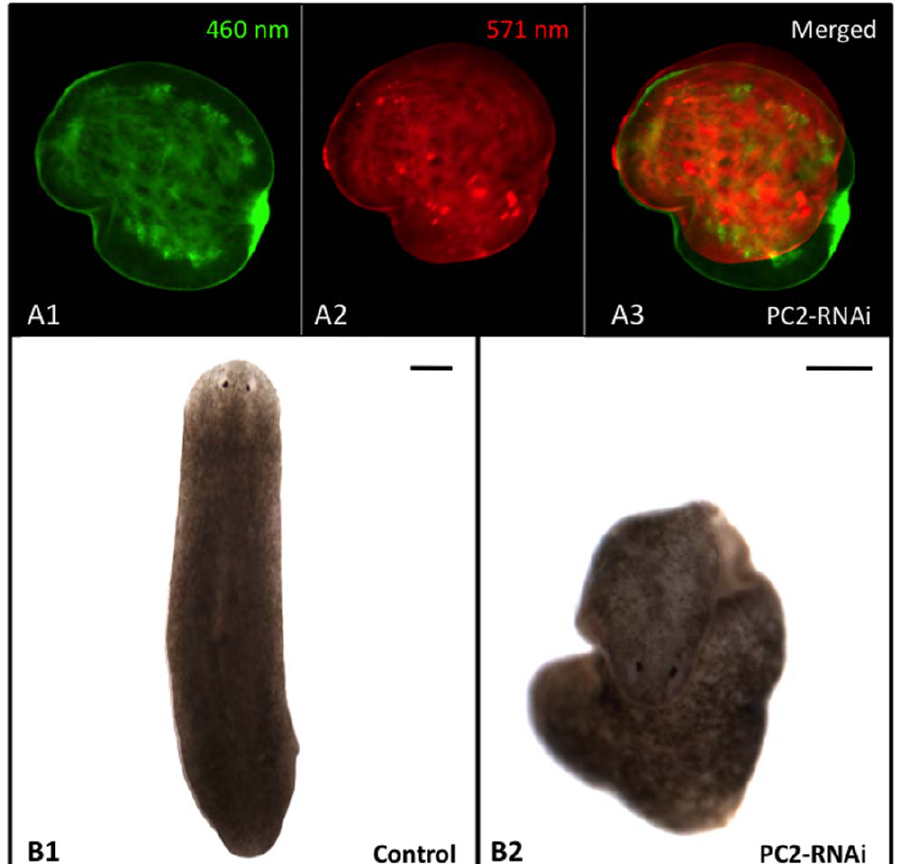
Figure 1. Need for An Improved Planarian Immobilization Technique. ( A ) Membrane Voltage Reporter Dye Assay . When consecutive images of a single planarian trunk fragment at 24 hours of regeneration showing ( A1 ) CC2 (460 nm) and ( A2 ) DiBAC (517 nm) staining are ( A3 ) overlaid, the failure of PC2-RNAi injection to prevent fine movements is illustrated. This assay requires correction of CC2 fluorescence using DiBAC, which is not possible when overlaid images are not in register (as in A3). Regenerates had to be injected with PC2-RNAi 2 weeks prior to amputation, well in advance of imaging. Anterior is to the right. ( B ) Characteristic Morphology . (B1) Untreated control and (B2) PC2-RNAi-injected worm (displaying typical curled phenotype). Anterior is up. Scale bars=250 m m.